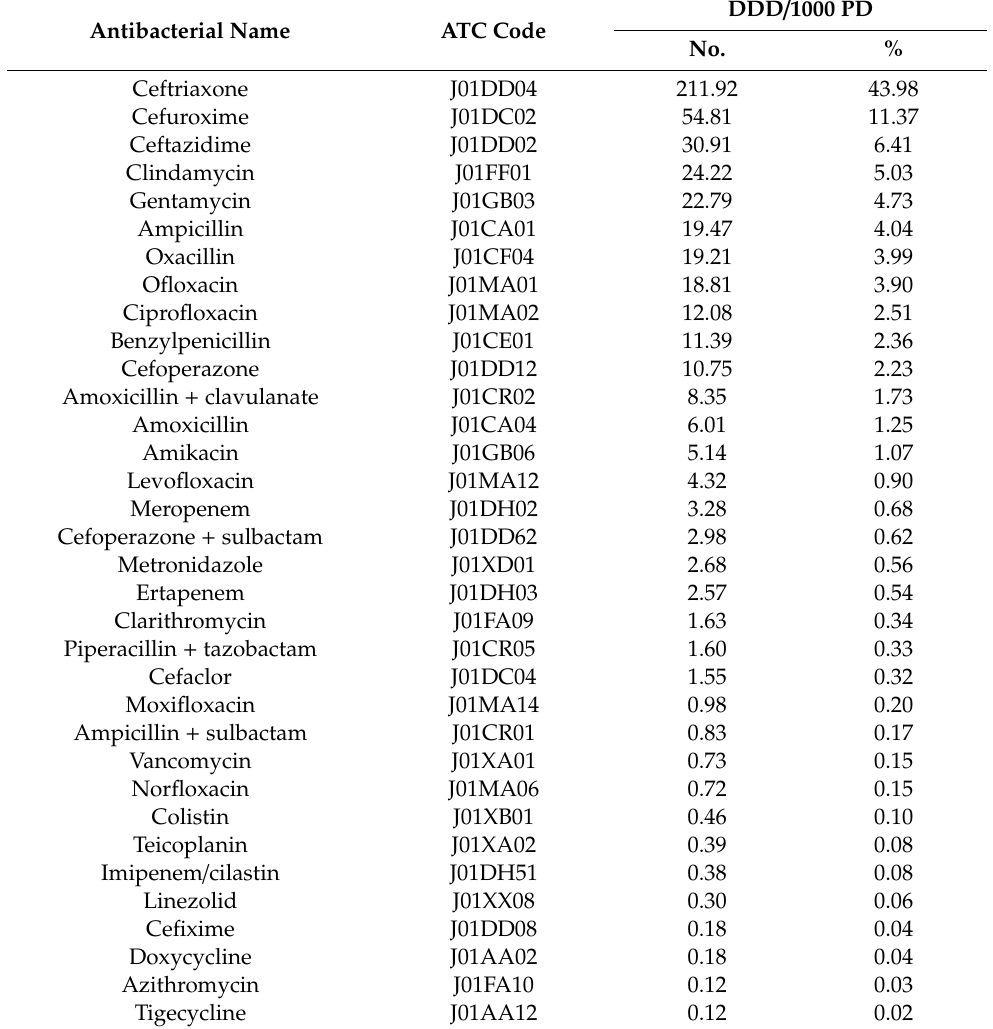
Table 2. Utilization pattern of antibiotics expressed as DDD / 1000 PD in the surgical wards.